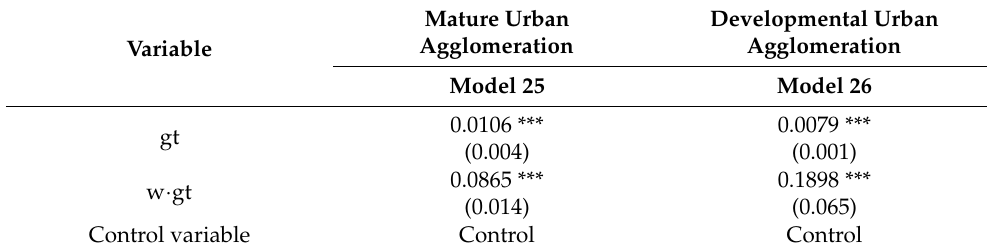
Table 12. Heterogeneity analysis results (Urban